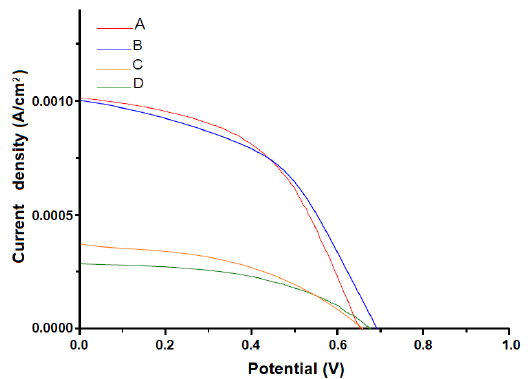
(A) and TiO support for Au Figure 10. j x V curves applying pure TiO 2 2 by wet impregnation (B), intimate (C) and evaporative (D) approach as photoanodes. Other conditions: electrolyte: tetrabutylammonium iodide (0.05M) / I (0.005M) / 4-tert-butylpyridine; FTO substrate; 2